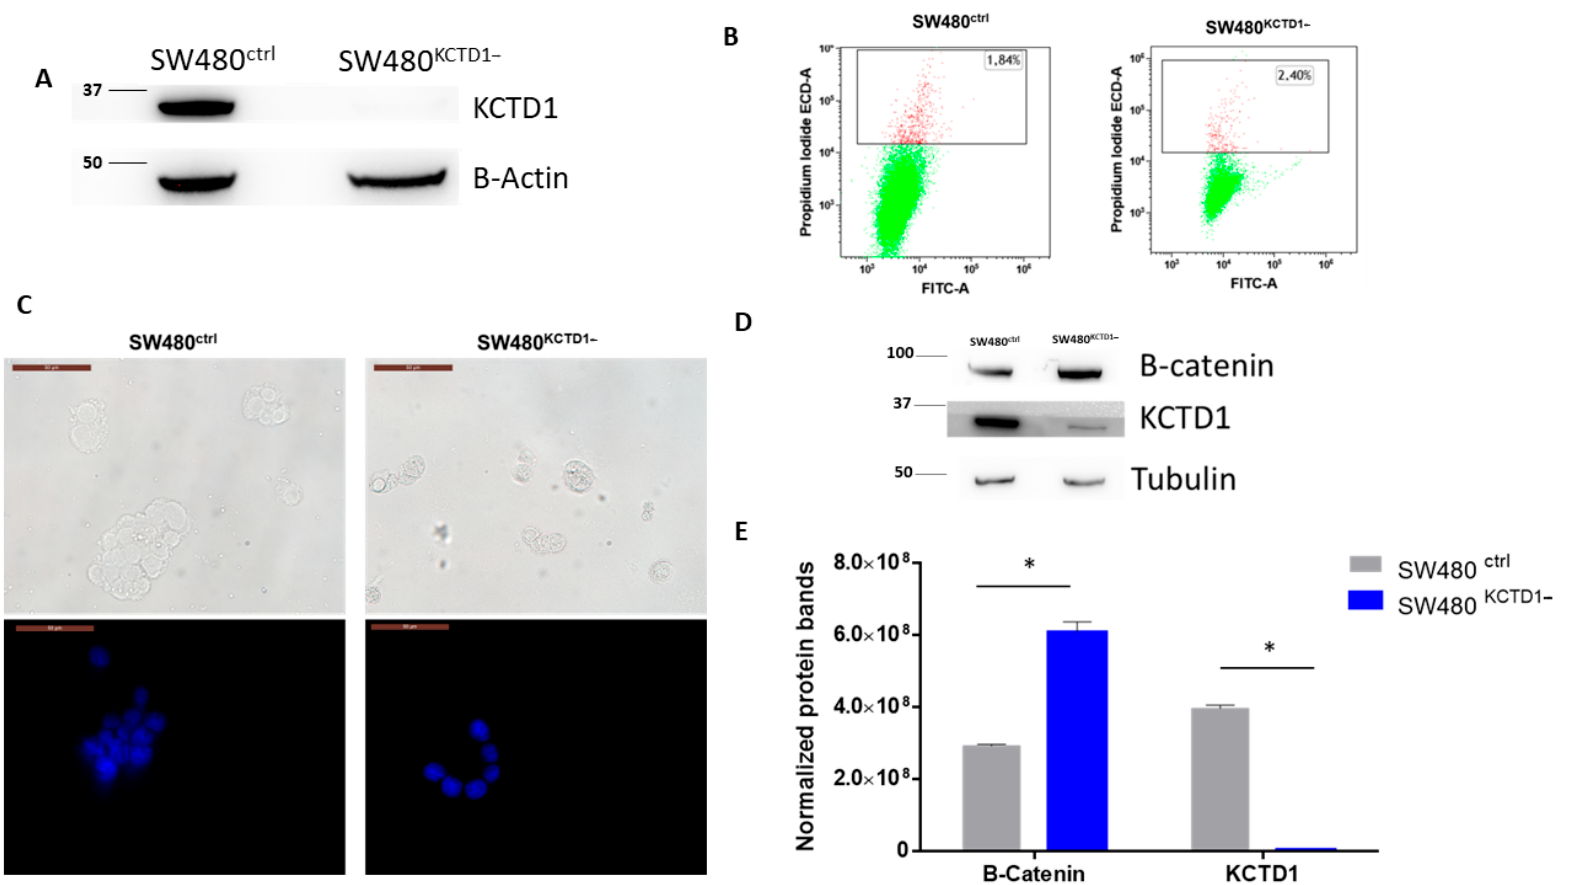
Figure 1. ( A ) Western blot analysis of SW480 ctrl and SW480 KCTD1 − cells. Numbers represent molecular weights expressed in Kda. ( B ) Propidium iodide VS FITC Dot plot analysis of SW480 ctrl and SW480 KCTD1 − cells. Numbers represent the propidium iodide-positive cells. ( C ) Bright fi eld- (top panels) and DAPI-stained (lower panels) microscopy of SW480 ctrl and SW480 KCTD1 − cells. Scale Bar 50 µm. Magni fi cation 40×. Western blot analysis of the indicated proteins ( D ) and protein band quanti fi cations ( E ) were performed on SW480 ctrl (grey bars) and SW480 KCTD1 − (blue bars) cells after 72 h of active growth. Numbers represent molecular weights of proteins expressed in kDa. * = p -value < 0.05.